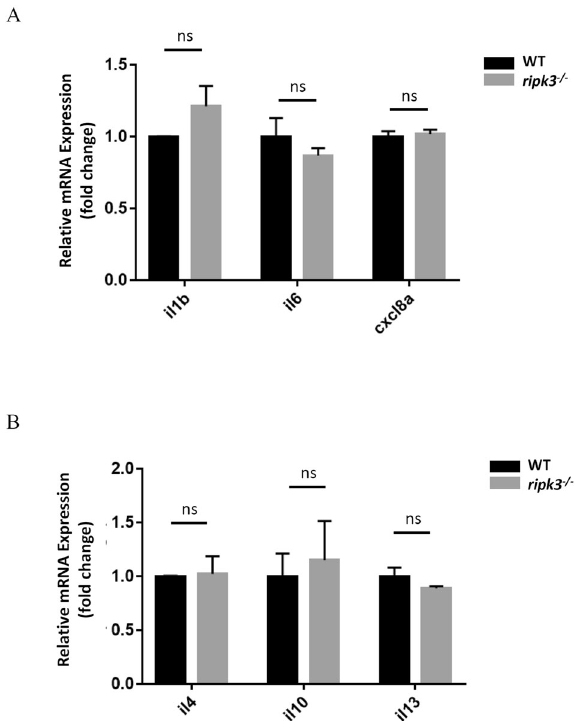
Fig. 3 The cytokine expressions kept unchanged in ripk3 - de fi cient larvae. A Normal pro-in fl ammatory cytokines expression upon ripk3 de fi ciency. The expression levels of il1b , il6 , and cxcl8a were unchanged in 3 dpf ripk3 -de fi cient larvae ( n ≥ 10, Student ’ s t - test). B Normal anti-in fl ammatory cytokines expression upon ripk3 de fi ciency. The expression levels of il4 , il10 , and il13 were